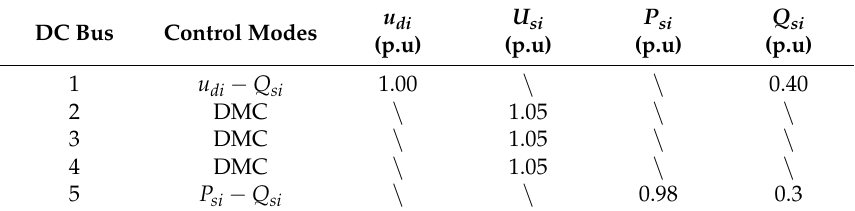
Figure 2. Modified IEEE 118-bus system with a VSC-Multiple Terminal Direct Current (VSC-MTDC) system. Table 2. Control Modes of VSCs.